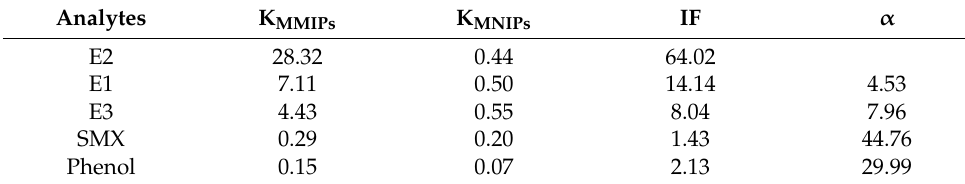
Table 1. Selectivity coefficient data of MMIPs and MNIPs for E2 and other four